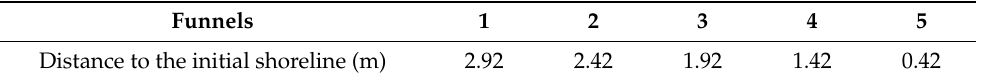
Table 1. Scenario A.1, funnels’ position. Cross-shore distances to the initial shoreline.